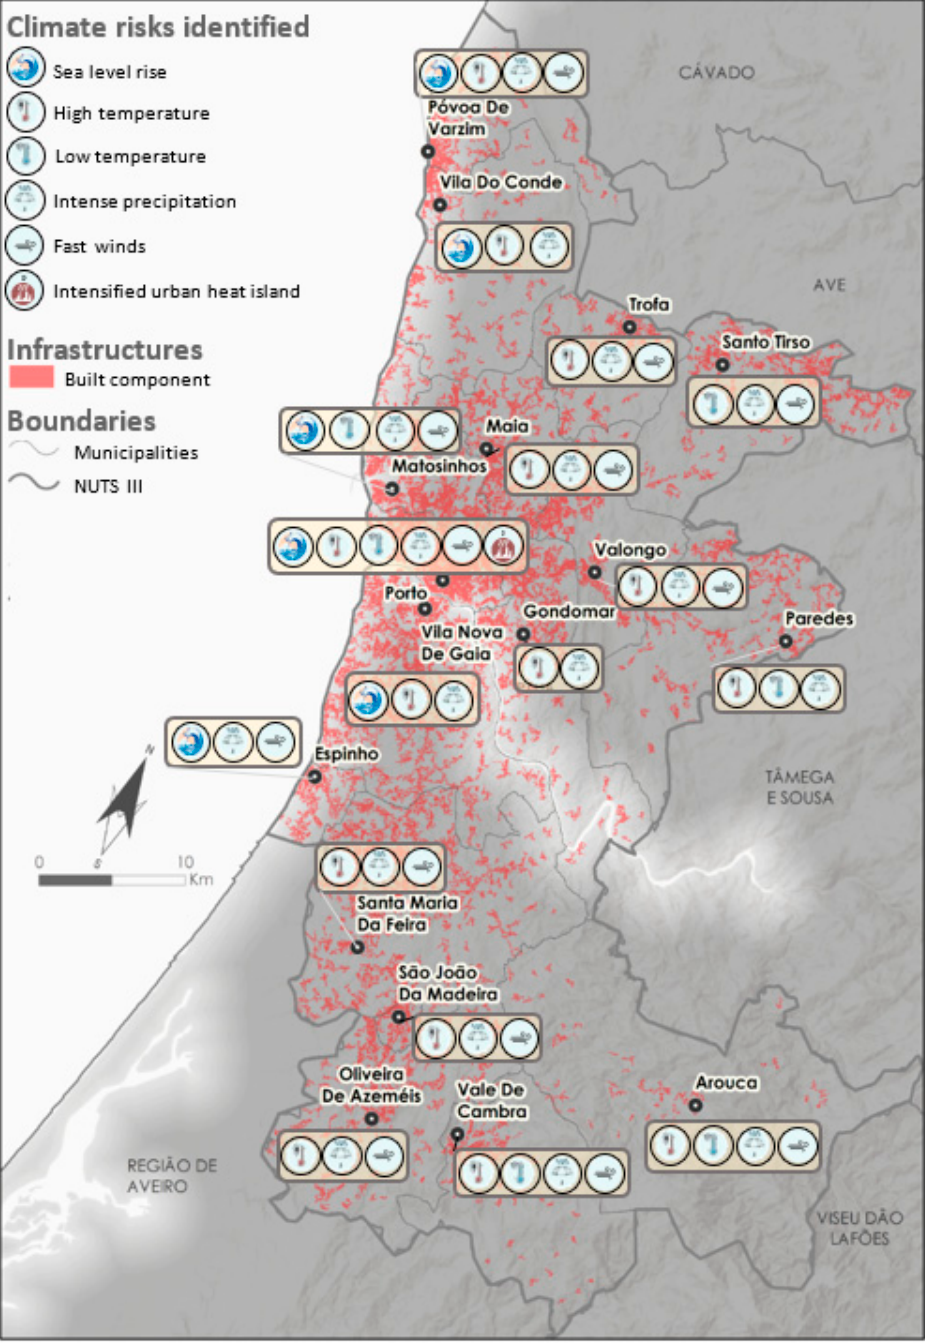
Figure 1. Study area—main climate risks identified. Source: Adaptation of Lopes (2022) [45].